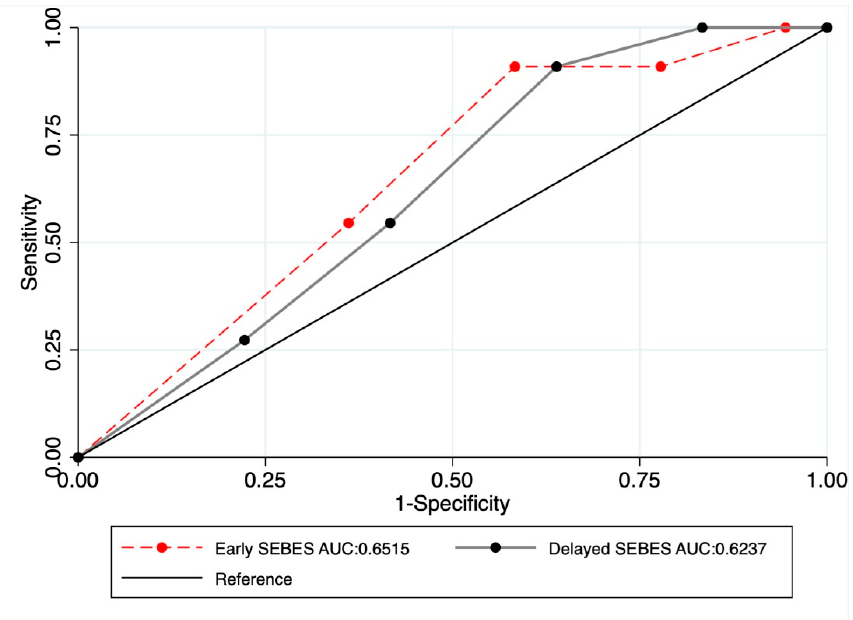
Figure 1. Receiver operating characteristics (ROC) and area-under-the-curve (AUC) analyses for SEBES (Early and Delayed SEBES) and the occurrence of Cerebral Infarctions (CI).